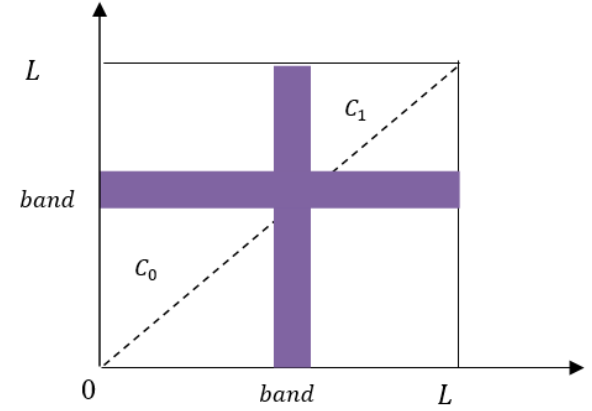
Figure 3. Improved Otsu method diagram.